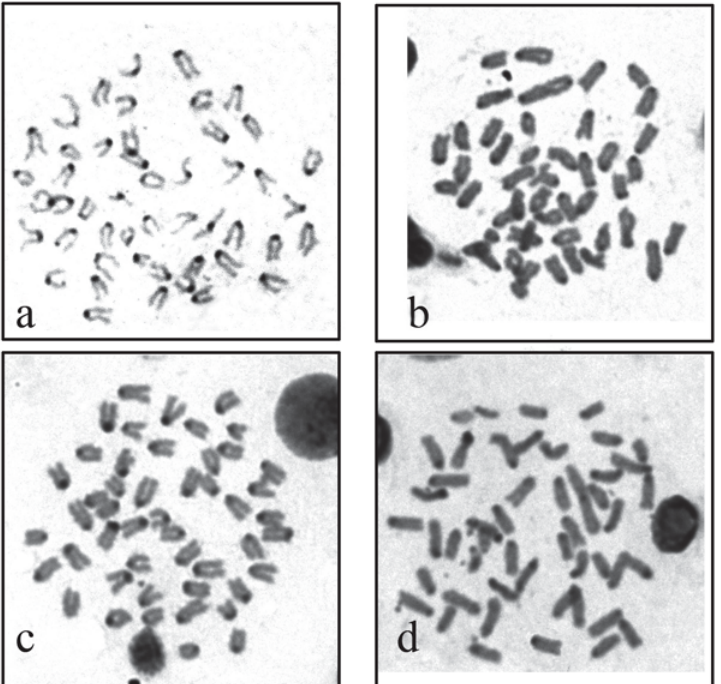
Fig. 2. C-banded metaphases of Lutjanus analis (a), L. griseus (b), L. synagris cytotype I (c) and L. synagris cytotype II